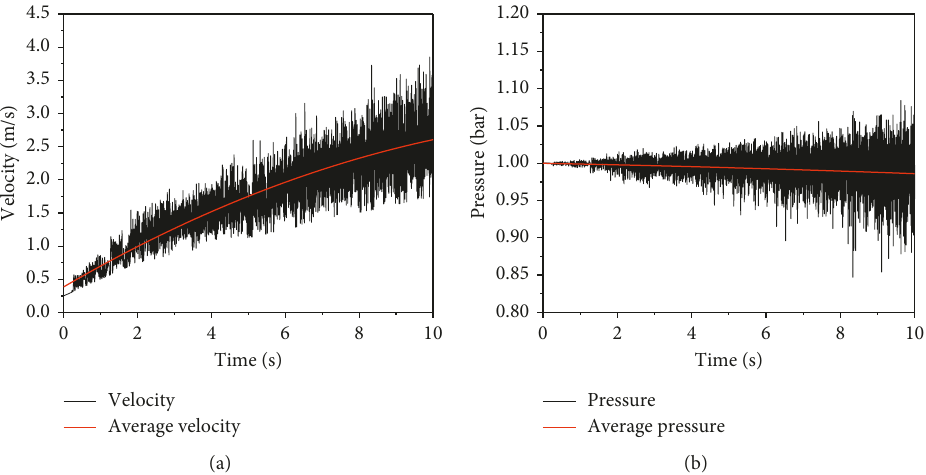
Figure 9: Curve for relationship between monitoring parameters and time. (a) Relationship between velocity and time. (b) Relationship between pressure and time.